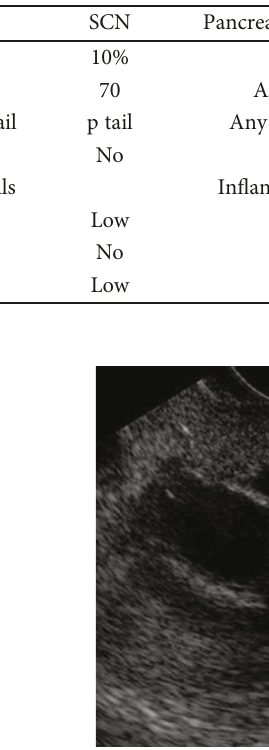
Table 1: IPMN: intraductal papillary mucinous neoplasm; MCN: mucinous cystic neoplasm; SCN: serous cystic neoplasm; SPN: solid pseudopapillary neoplasm; p: predominantly; HOP: head of pancreas.